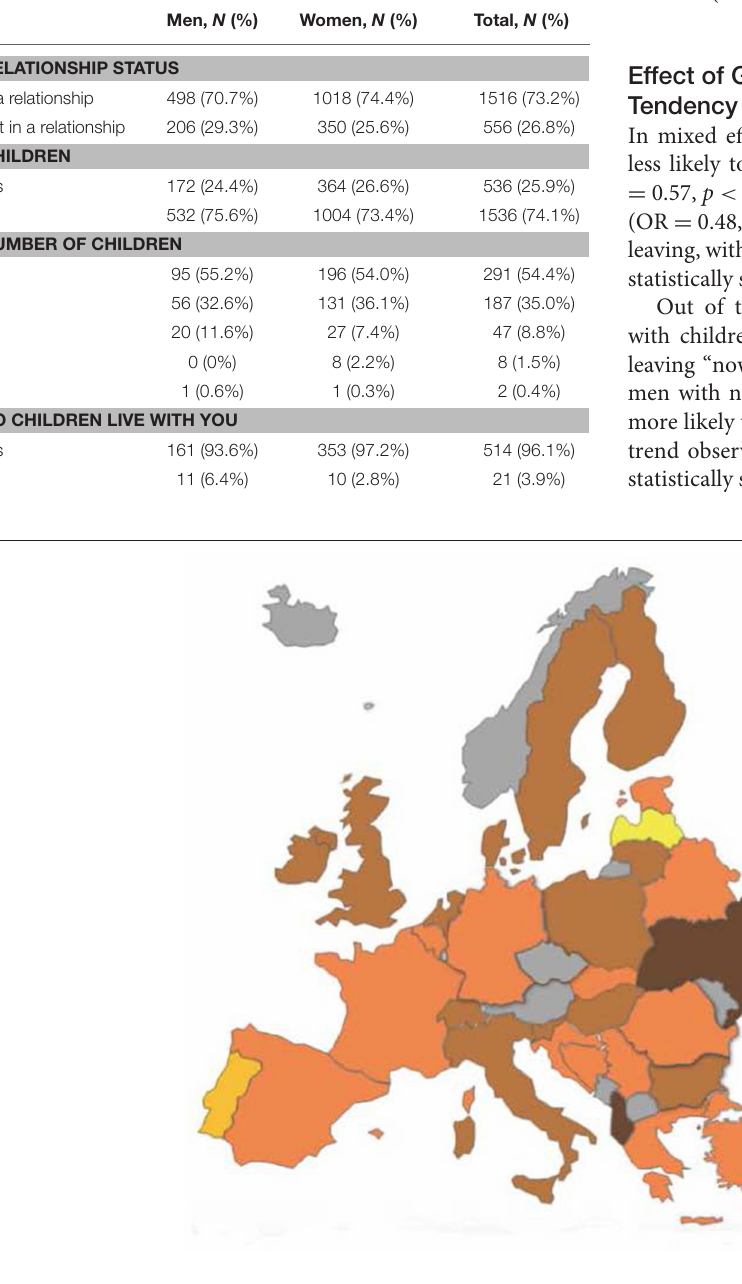
FIGURE 1 | Psychiatric trainees